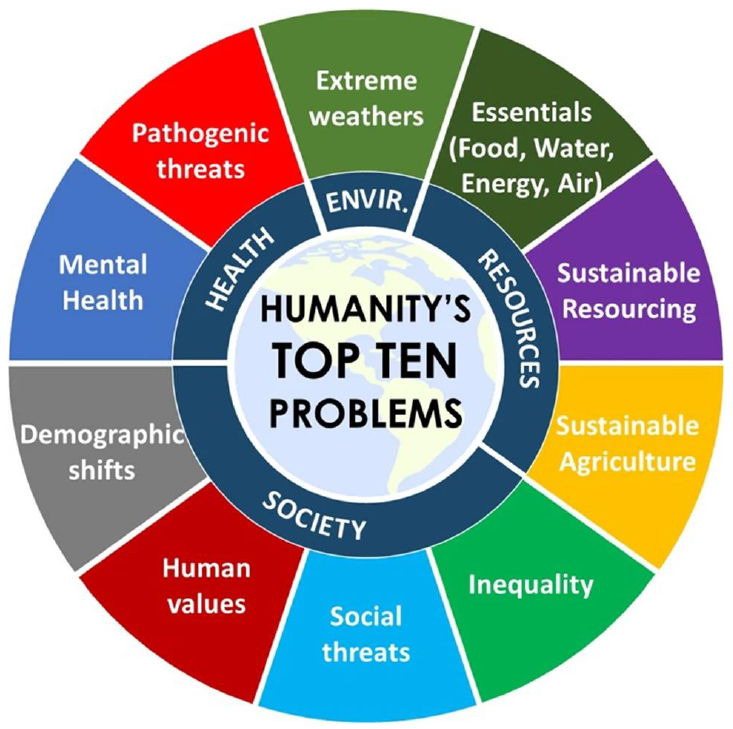
Figure 4. Humanity ’ s top 10 major concerns [2]. Figure 4. Humanity’s top 10 major concerns